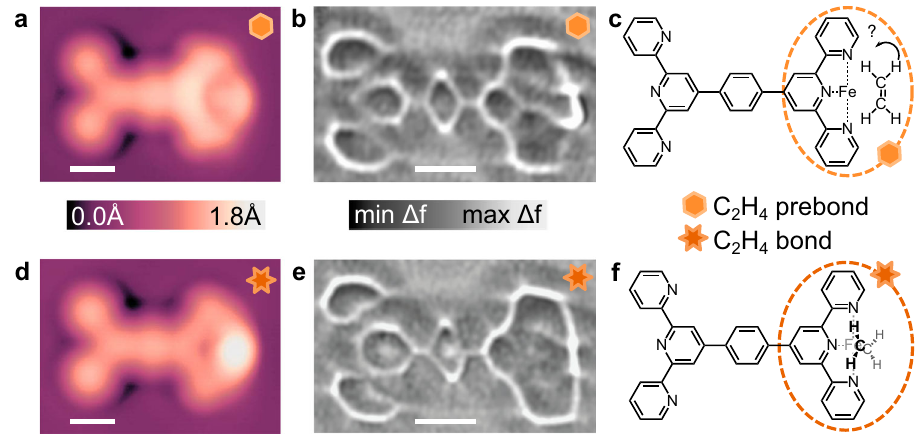
Fig.4|STMandncAFMofC 2 H 4 associatedFe-tpystructures. Topographsofthe performed on ( b ) to compensate for drift. Proposed chemical structures for the horizontal C 2 H 4 prebond and vertical C 2 H 4 bond motifs drawn in ( c ) and ( f ), C 2 H 4 prebond ( a ) and C 2 H 4 bond ( d ) con fi gurations imaged at V =20mV and I =10pA.Laplace- fi lteredncAFMimagesoftheC respectively; note for the pre-bond structure, surface adsorption would indicate a 2 H 4 prebond( b )andC 2 H 4 bond( e ) fl at-lying structure as shown, while DFT shows a weakly bonded side-orientation. motifs imaged at constant height with A vib =2Å from a setpoint of V =20mV and I =10pA on Ag(111). Δ z = − 0.01nm for ( b ), and Δ z = − 0.022nm for ( e ). Images Scalebars 5Å ( a , b , d , e ( a , b , d , e )wereallacquiredwiththesameCO-terminatedtip.Sheartransformation